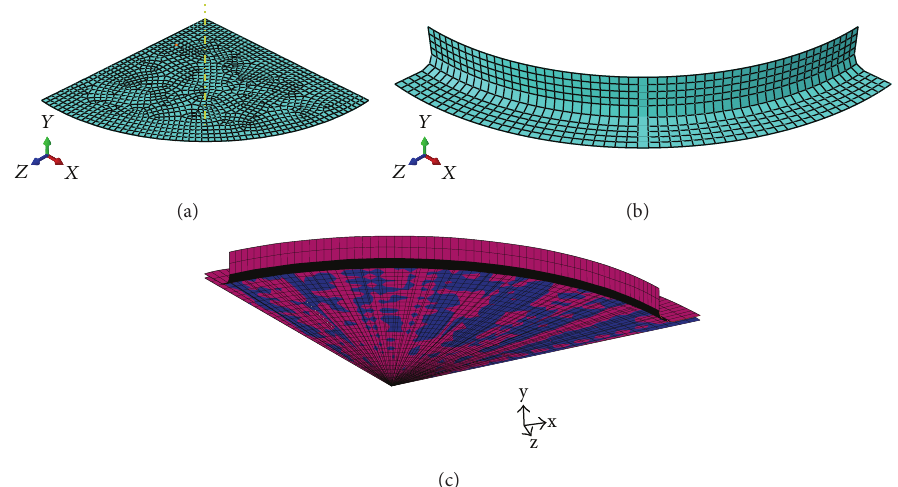
Figure 11: FEM element mesh. (a) Abaqus. (b) Discrete rigid finite elements at the clamp. (c) MSC-MARC.